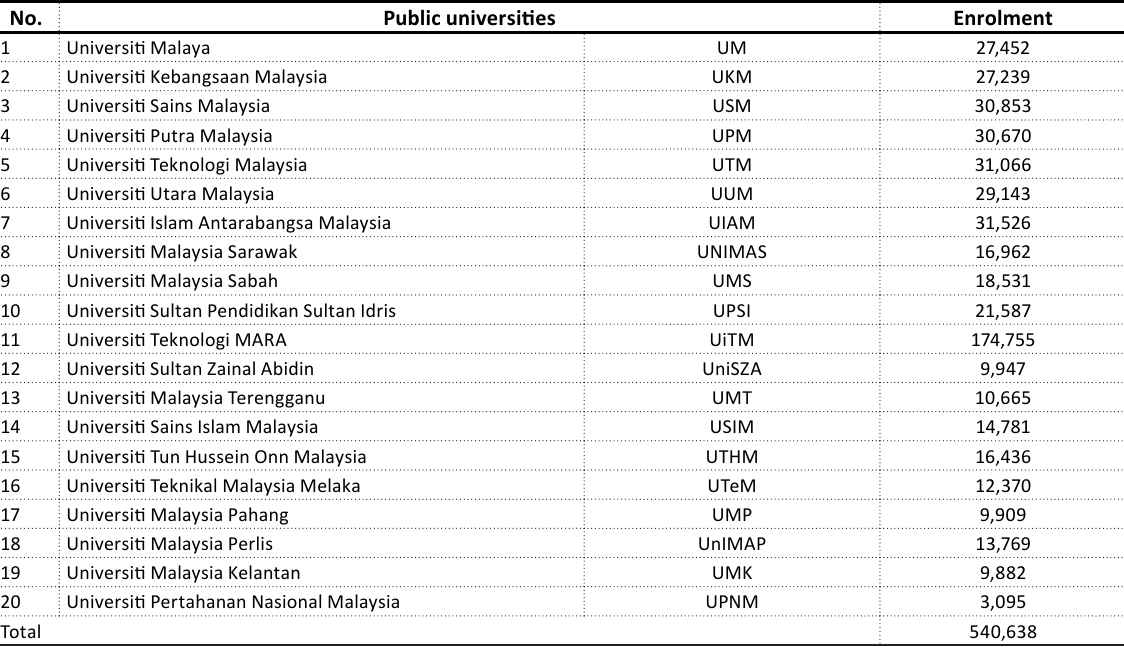
Source: Planning, Research and Policy Coordination Division, MOE (2016).